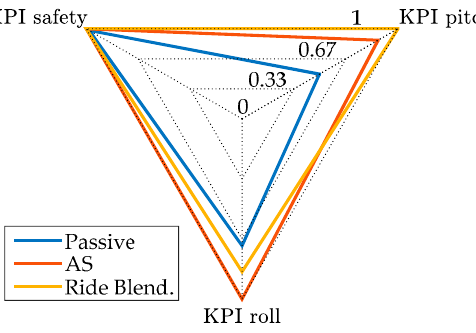
Figure 14. Key performance indexes for the brake-in-turn test. The electronic brake distribution (EBD) for minimum pitch improves the pitch motion to the detriment of the roll dynamics.